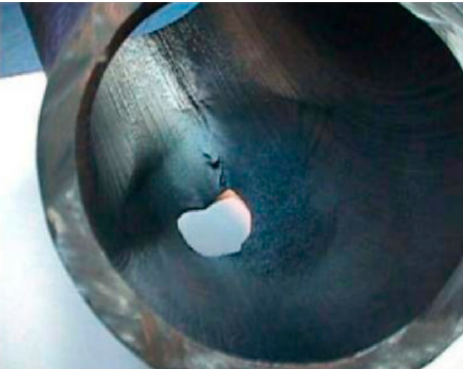
Figure 2. Elbow perforated by erosion.